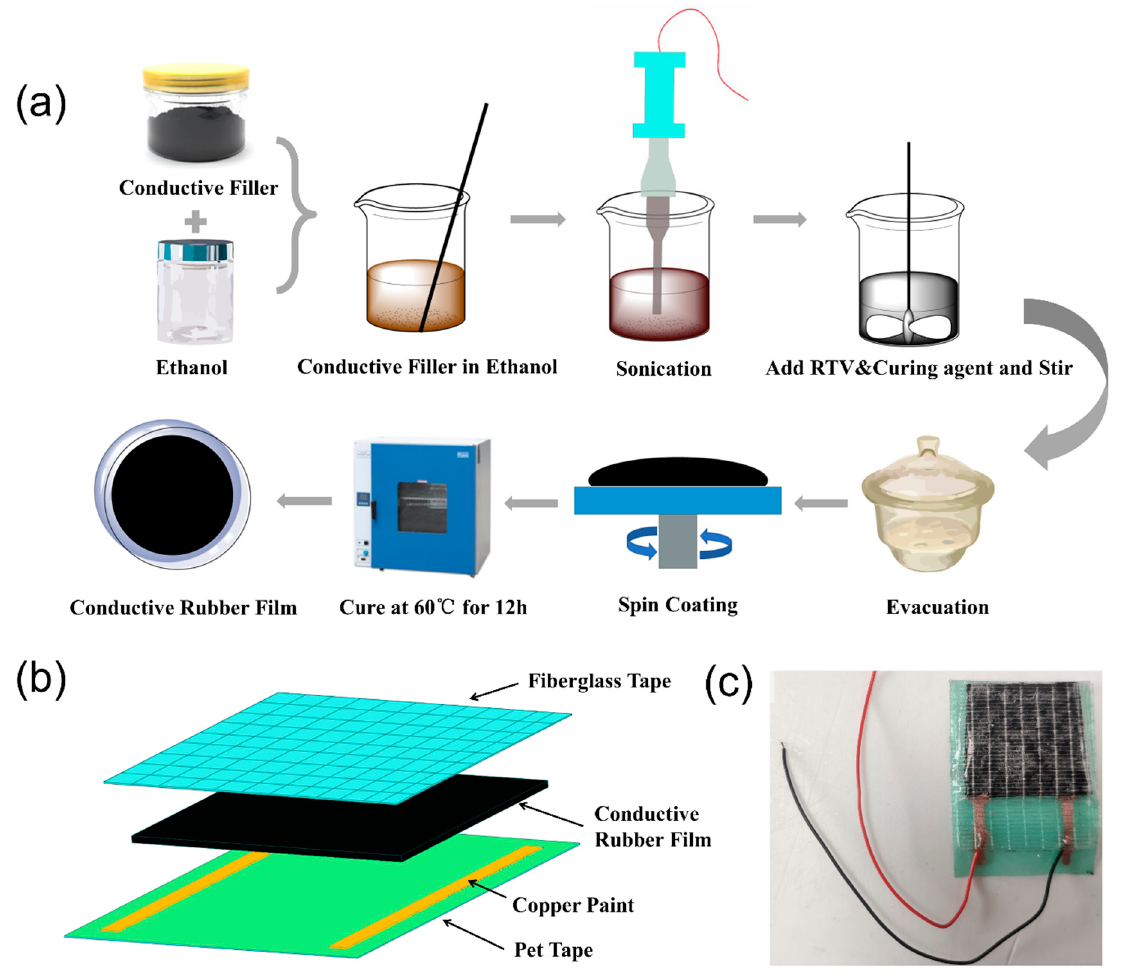
Figure 1. ( a ) Schematic of the conductive rubber composite fabrication process, ( b ) structure of the fabricated stretchable tactile sensor, and ( c ) photograph of the fabricated stretchable tactile